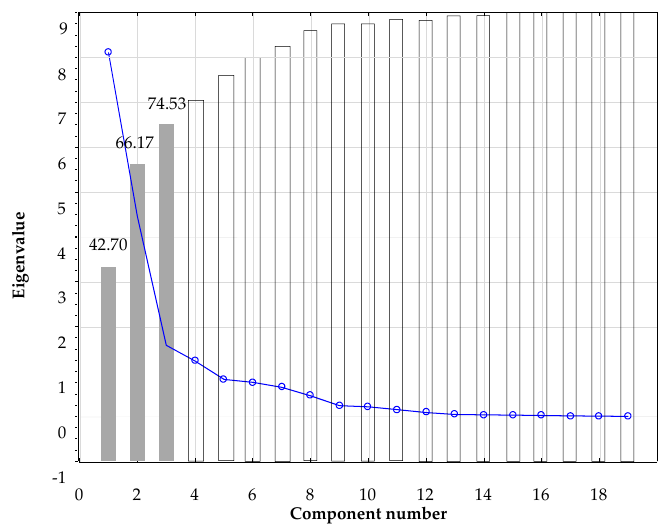
Figure A3. Mean degree of polymerization distributed by Rioja wine “types”. Error bars are standard deviation of wine samples within each category.